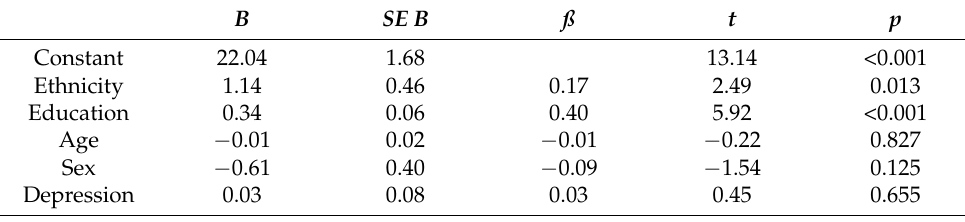
Table 4. Linear regression analysis for German and Turkish sample on Cognition measured with MoCA ( n =